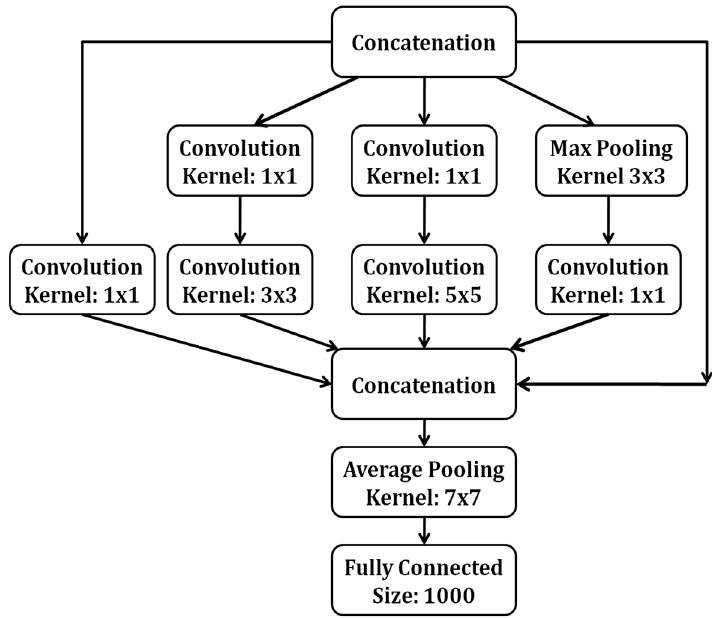
Figure 4. Google NET.